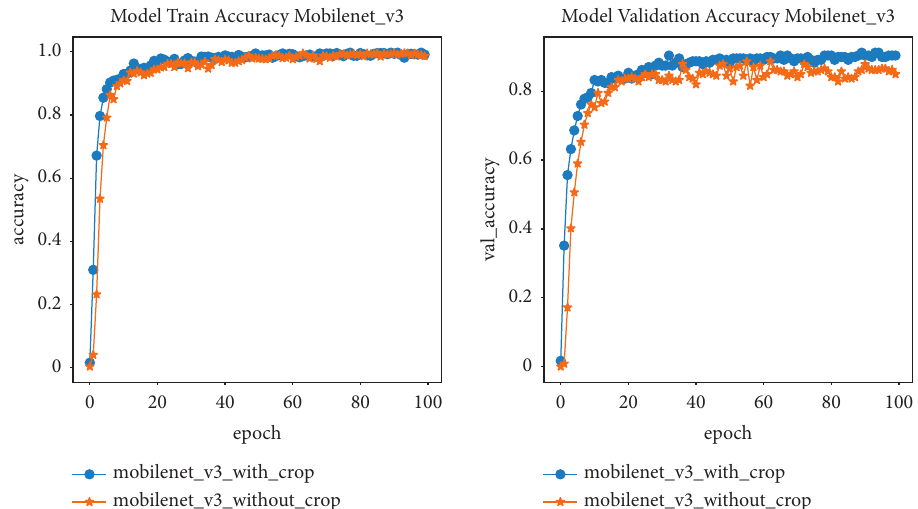
Figure 8: Accuracy of MobileNetV3 network architecture before and after normalization.